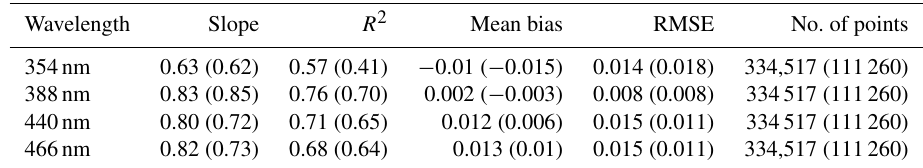
Figure 1. Scatterplots of OMI-derived LER vs. GLER for two months in 2006 (January on left and July on right) with possible sunglint removed at four wavelengths (354, 388, 440, and 466nm). Data are for deep ocean (based on OMI Level 1b ground pixel quality flags) and have been screened for aerosols (OMAERUV | AI | < 0.5). Clouds are screened through two different methods which are described in Sect. 2.6. Only data with a solar zenith angle less than 70 ◦ are included as cloud shadowing at high view angles can decrease the OMI-derived LER. Table 1. Statistical analysis of GLER vs. OMI LER for nonsunglint scenes. January (July) 2006 deep ocean only with Raman-based ECF = 0.0 (corresponds to the second and fourth column of Fig.